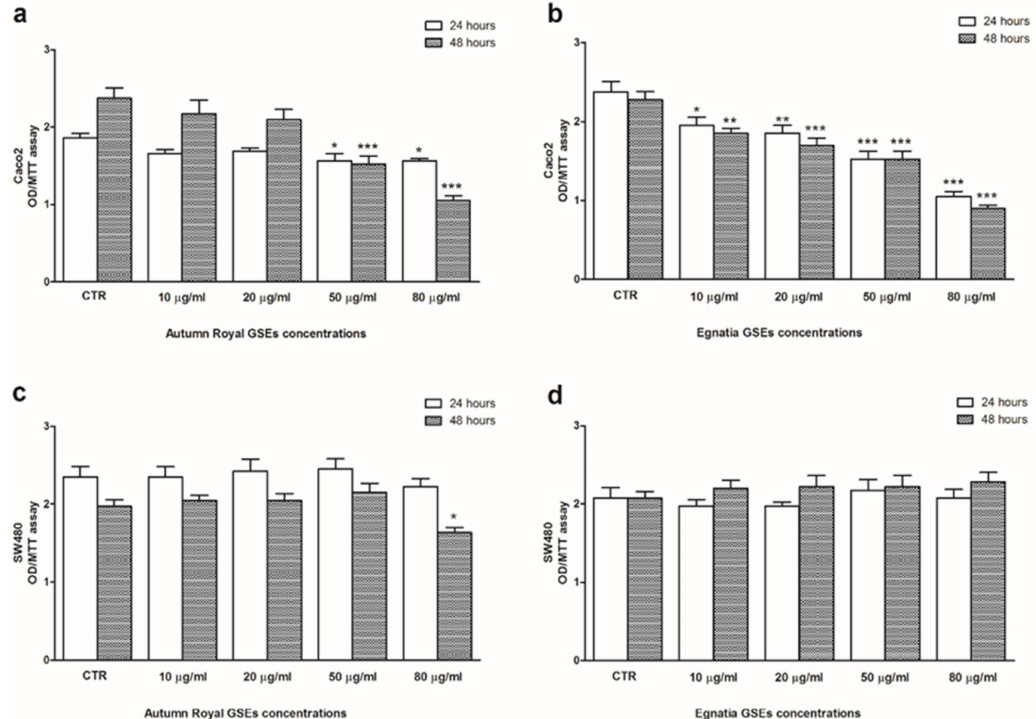
Figure 1. ( a ) E ff ects on cell proliferation of Caco2 cell line treated with increasing concentrations of Autumn Royal GSEs (10, 20, 50, and 80 µ g / mL), for 24 and 48 h of incubation; ( b ) E ff ects on cell proliferation of Caco2 cell line treated with increasing concentrations of Egnatia GSEs (10, 20, 50, and 80 µ g / mL), for 24 and 48 h of incubation; ( c ) E ff ects on cell proliferation of SW480 cell line treated with increasing concentrations of Autumn Royal GSEs (10, 20, 50, and 80 µ g / mL), for 24 and 48 h of incubation; ( d ) E ff ects on cell proliferation of SW480 cell line treated with increasing concentrations of Egnatia GSEs (10, 20, 50, and 80 µ g / mL), for 24 and 48 h of incubation. All data are expressed